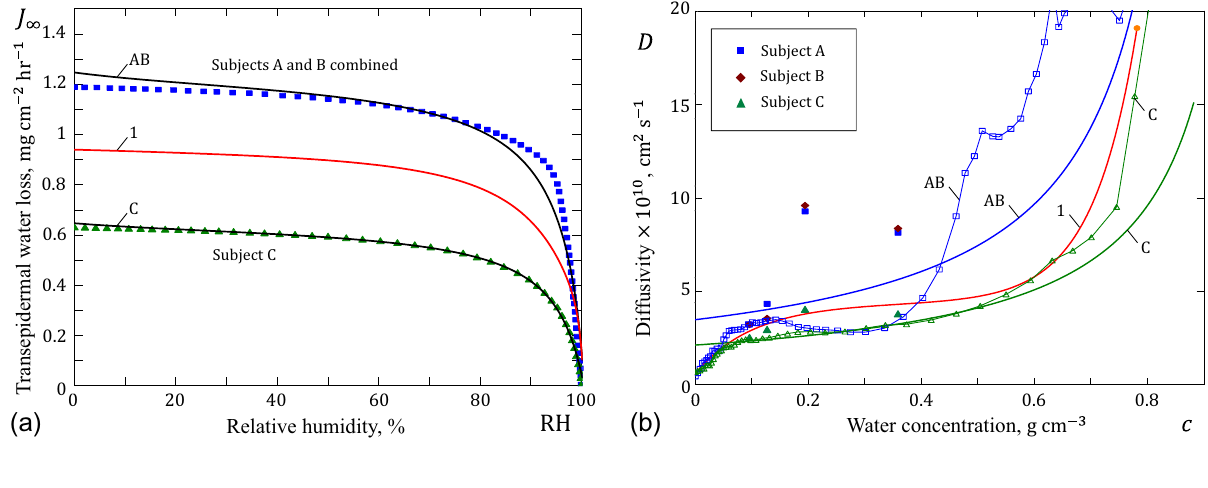
as a function of relative ∞